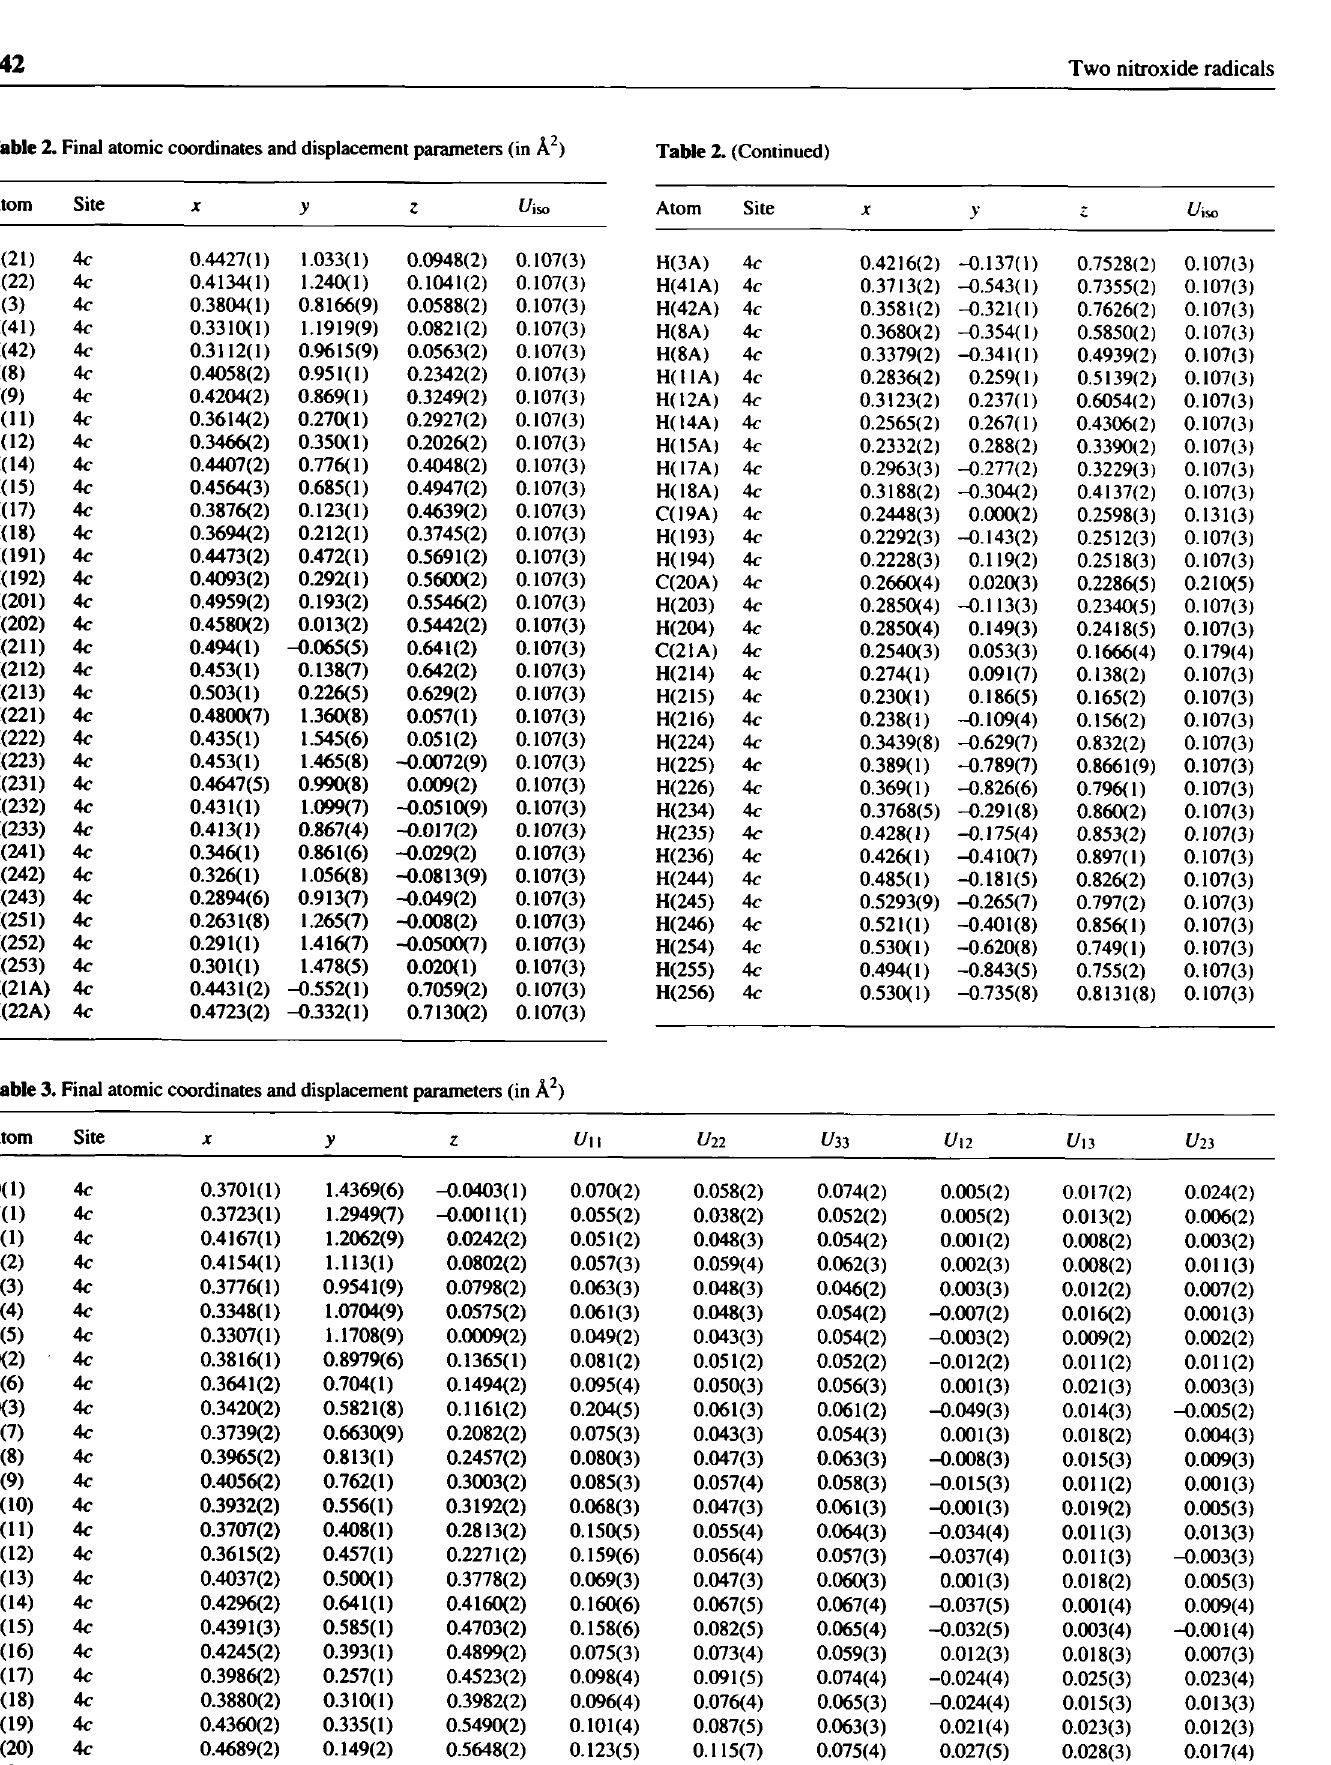
Table 3. Final atomic coordinates and displacement parameters (in